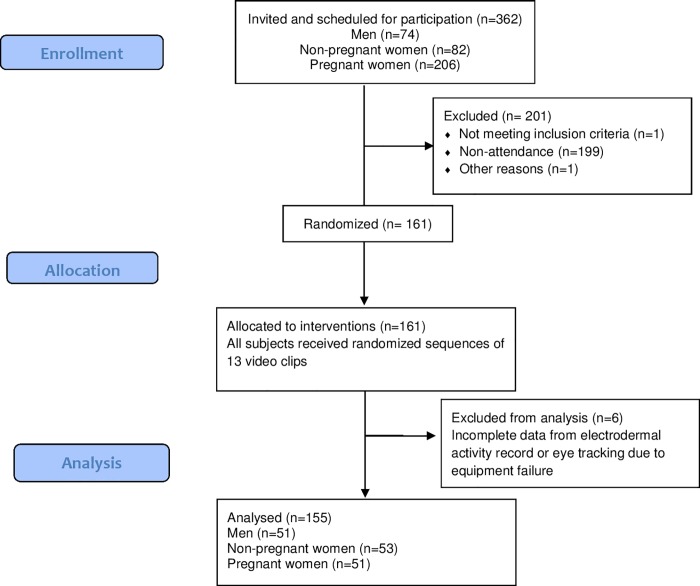
CONSORT flow diagram of subject recruitment, allocation and analysis.